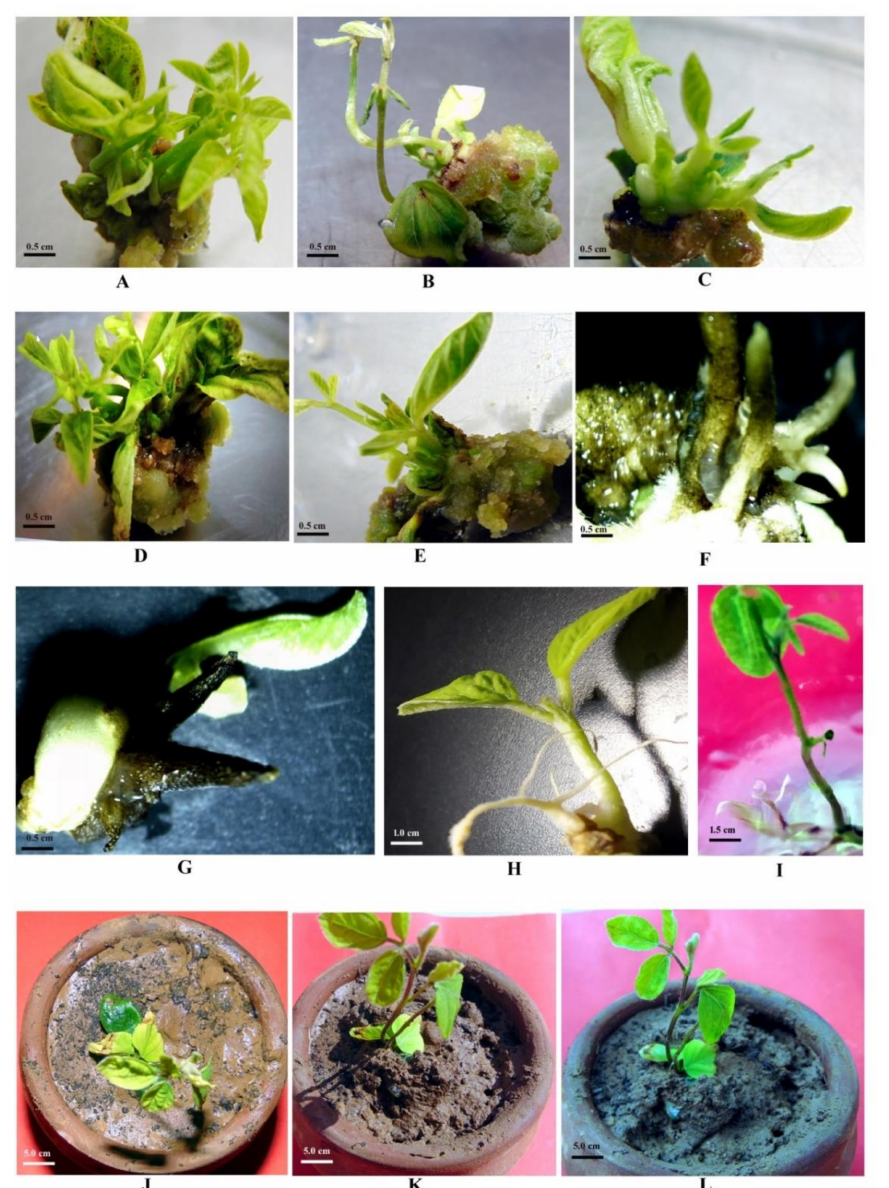
Figure 4. Effect of different concentrations of PEG6000 on regeneration of plantlets obtained from tolerant calli/cell clumps/embryoids in soybean. ( A ) PEG6000 0% ( w/v ); ( B ) PEG6000 5% ( w/v ); ( C ) PEG6000 10% ( w/v ); ( D ) PEG6000 15% ( w/v ); ( E ) PEG6000 20% ( w/v ); ( F ) PEG6000 25% ( w/v ); ( G ) PEG6000 30% ( w/v ); ( H , I ) Rooting of regenerants; ( J ) Regenrant transferred in greenhouse for hardening;( K , L ) Regenerants transferred in nethouse for